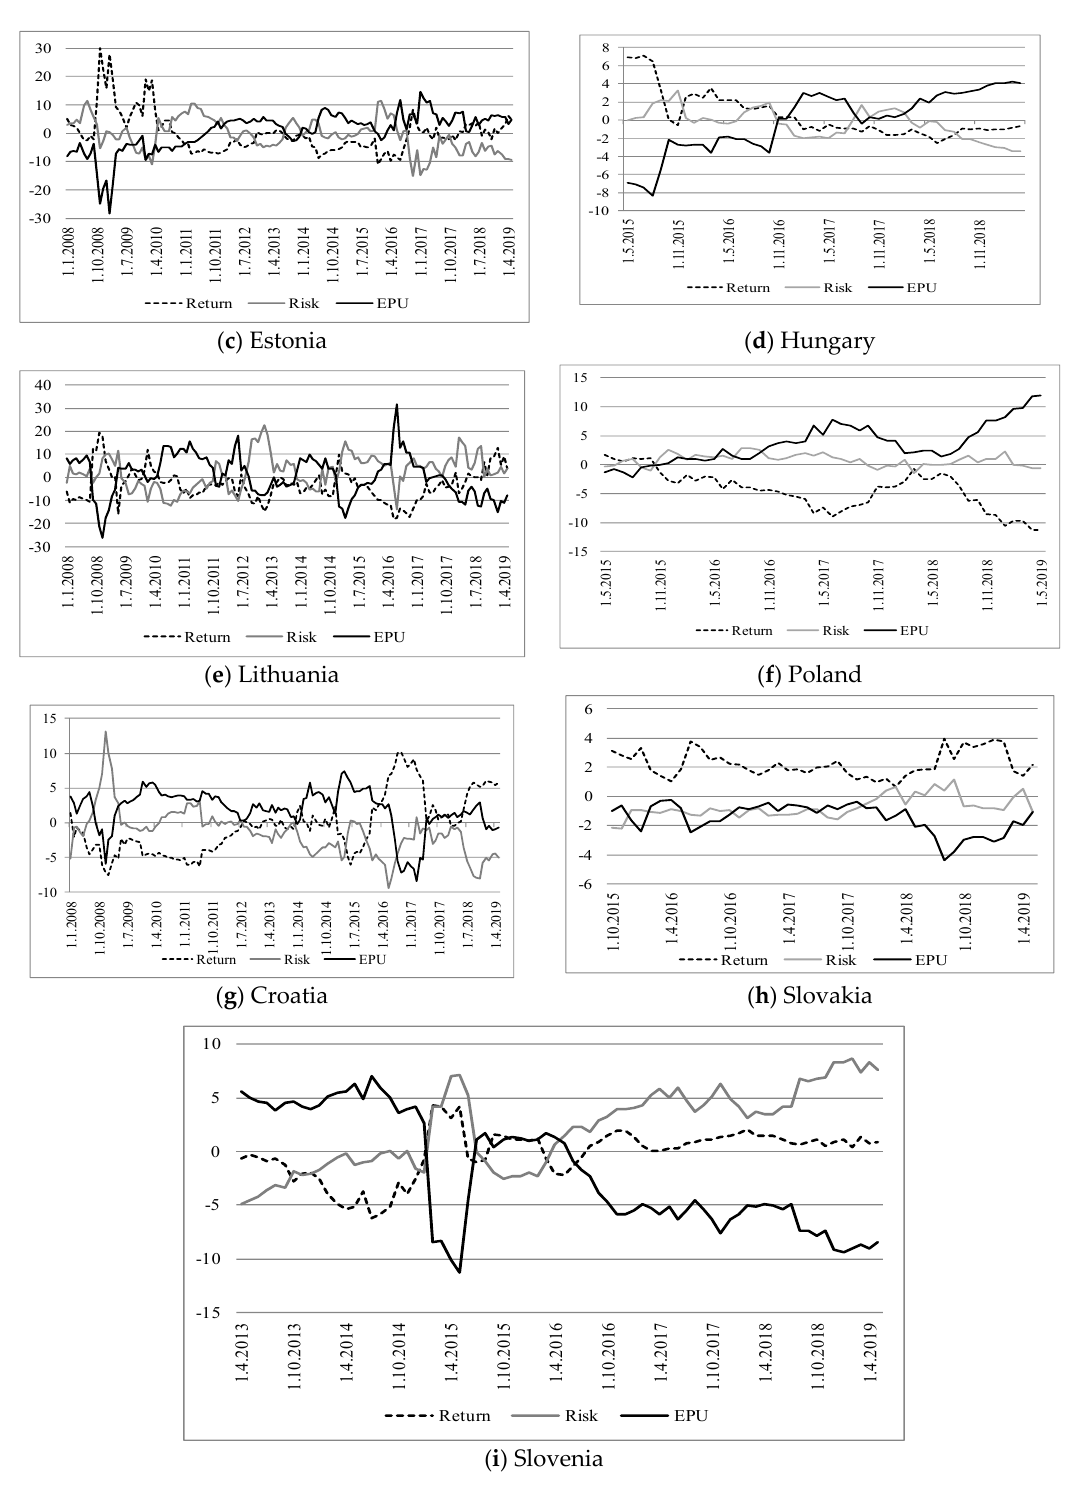
Figure A3. Rolling net spillover indices for every country.